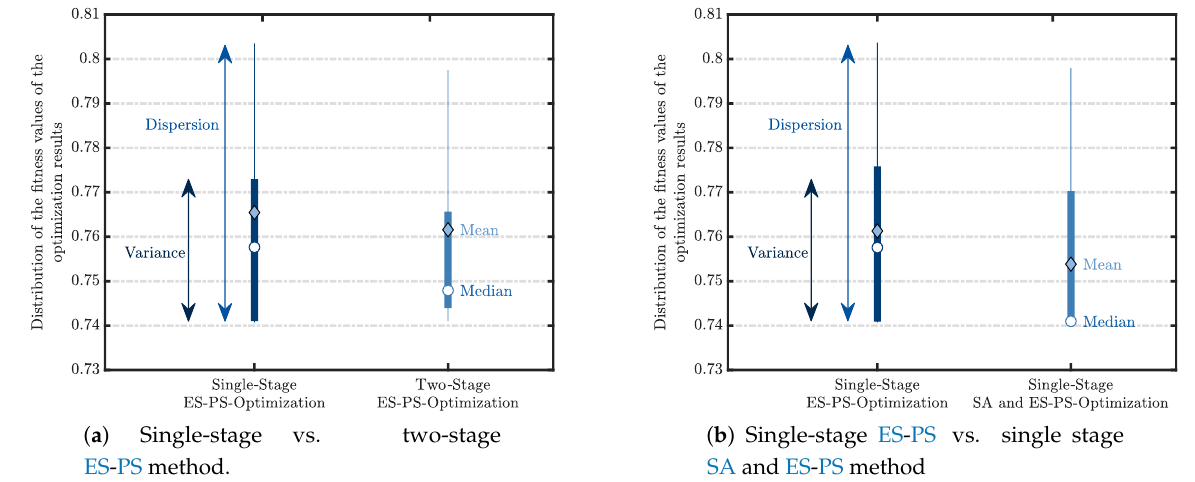
Figure 5. Comparison of the distribution of results for different optimization